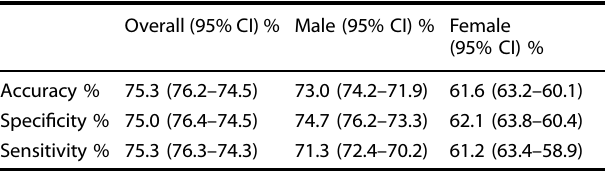
Fig. 2 PCA 3D score plot of the whole study population. Each dot represents a 0.02 ppm bucketed 1D-NOESY 1 H-NMR spectrum color- coded by subject groups. Table 1. Performances of the OPLS-DA 1D-NOESY models discriminating dn 2 PD patients from CTR subjects of the training cohort.